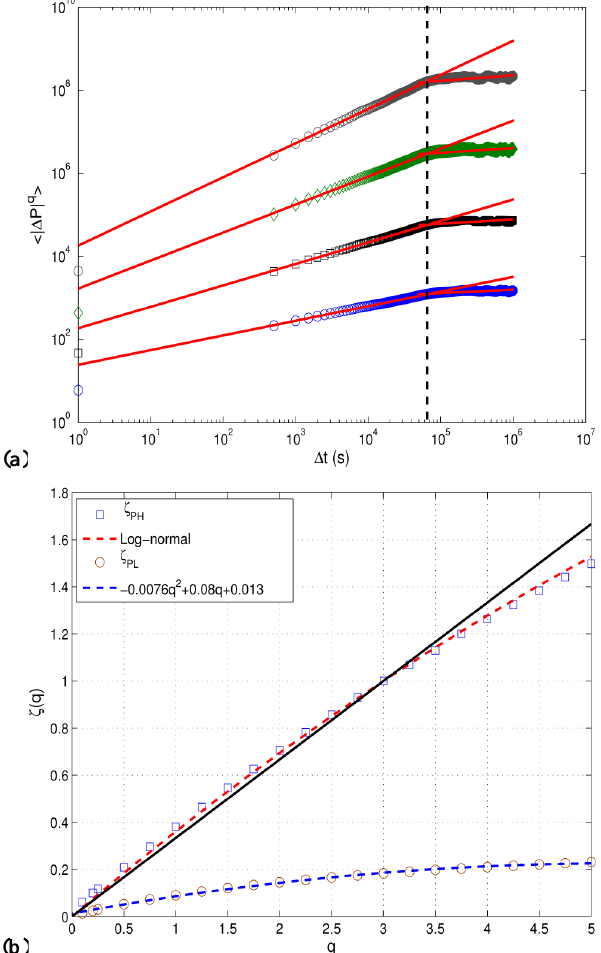
Fig. 6. (a) The scaling of the structure functions for wind power S P (q) illustrating two scaling regimes: for 1 6 1t 6 6 . 5 × 10 4 s and for 6 . 5 × 10 4 6 1t 6 10 6 s. (b) The empirical scaling exponent function ζ PH (q) ( (cid:3) ) estimated for 1 6 1t 6 6 . 5 × 10 4 s and com- pared to the K41 model (black solid line) and the lognormal model (red dashed line). The empirical scaling exponent function ζ PL (q) ( ◦ ) compared to a quadratic fit (blue dashed